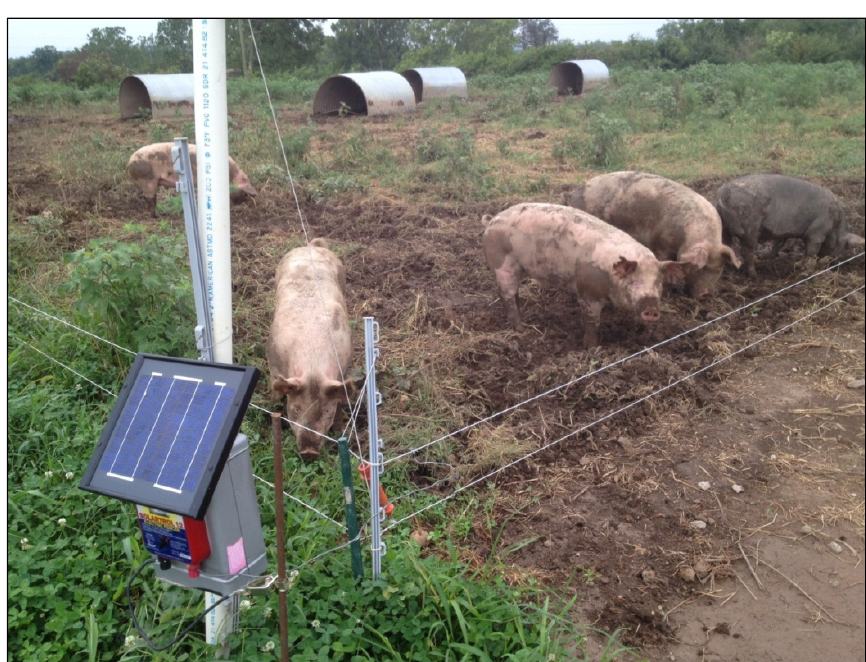
Figure 7. Hogs Produced Outside on the Berea College Student Farm Using Portable Electric Fencing for Controlling Grazing and Rooting and Provided with Deep-Bedded Hoop